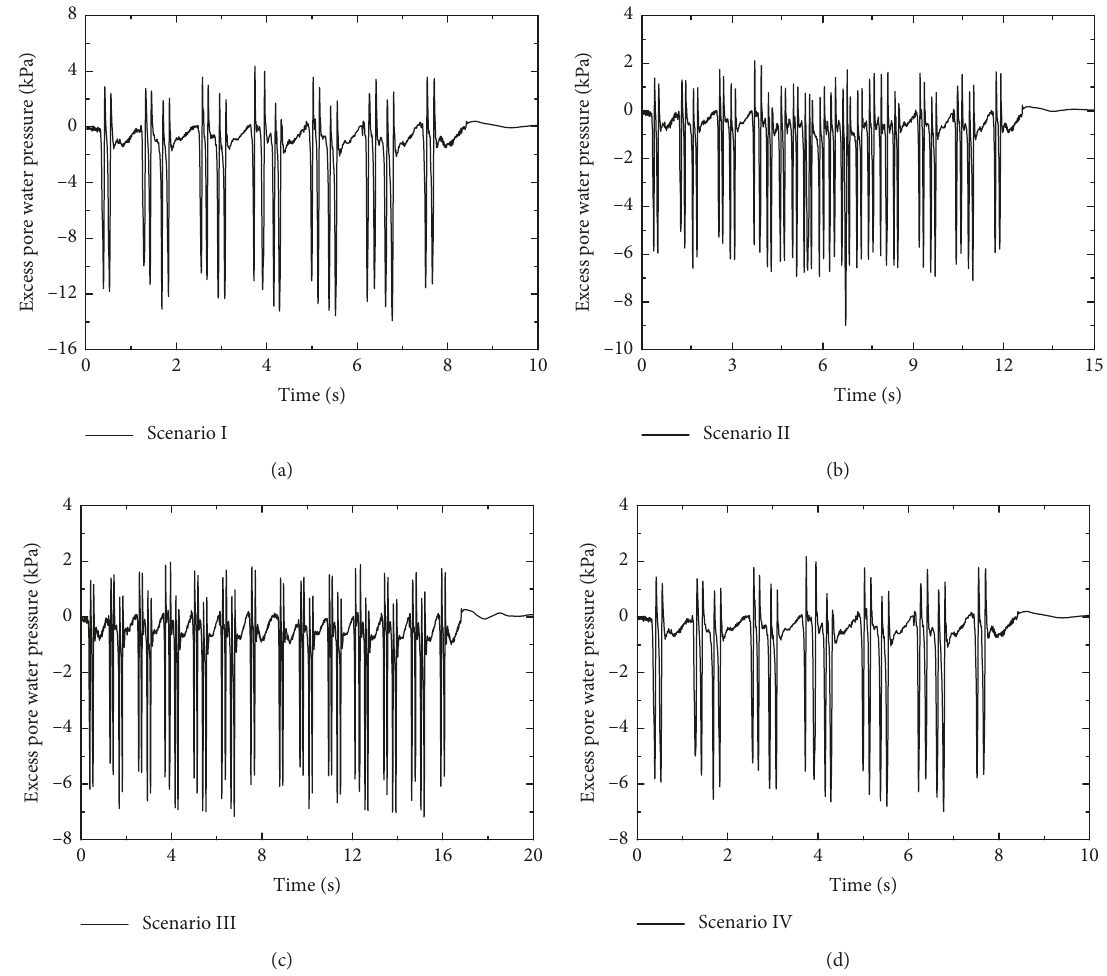
Figure 18: The excess pore pressure of A 1 in time domain. (a) Scenario I. (b) Scenario II. (c) Scenario III. (d) Scenario